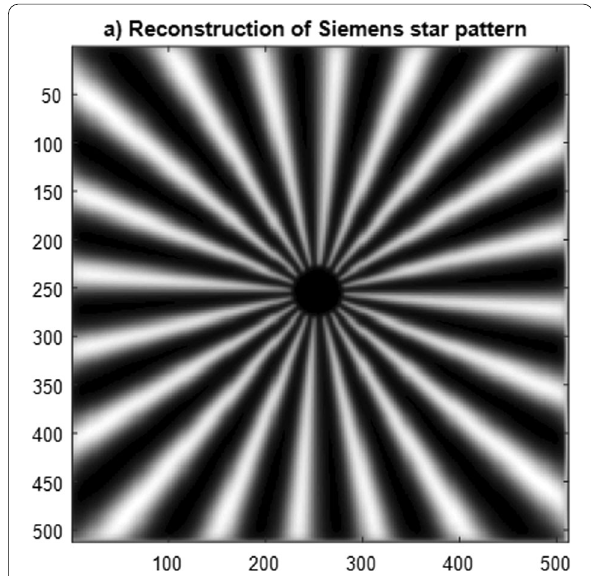
Fig. 12 Reconstructed images using the CSLM provided with the second model of polynomial aperture